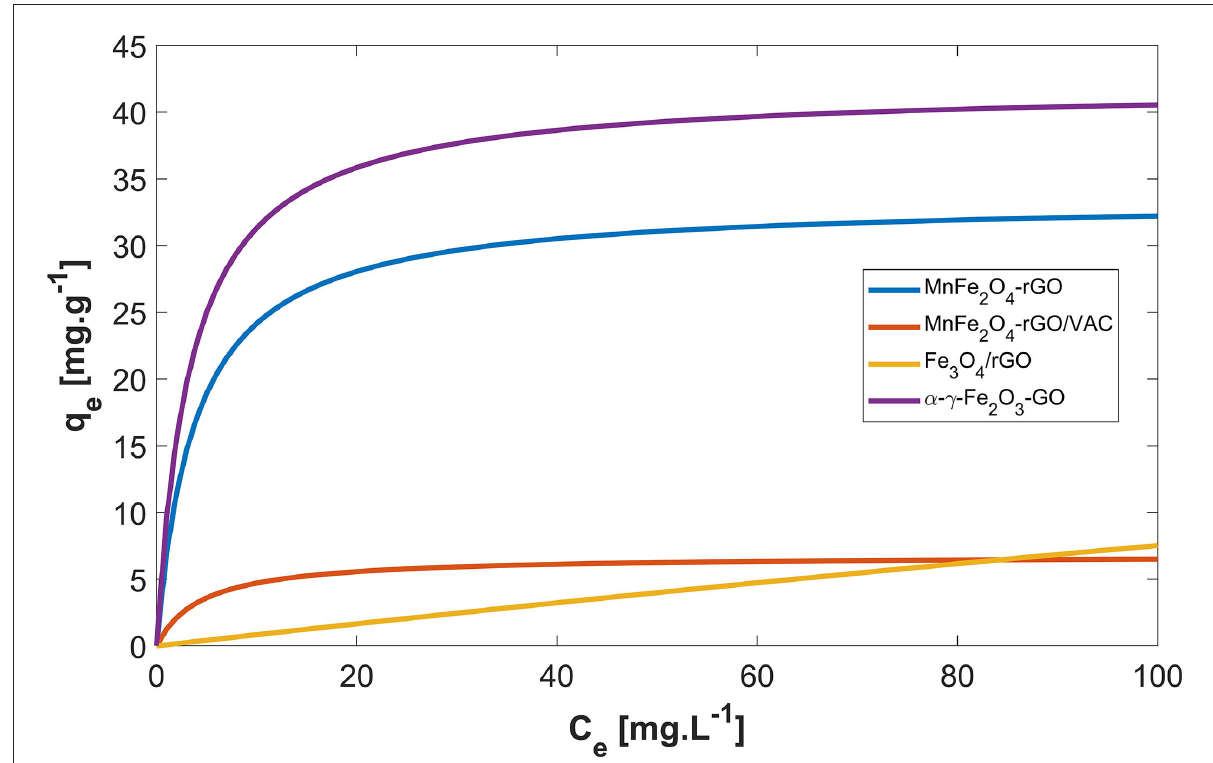
FIGURE2 Simulated Langmuir isotherms using the parameters K L and q m calculated by the cited authors (Ueda Yamaguchi et al., 2016; Li et al., 2018; Marin et al., 2019; Santos et al.,